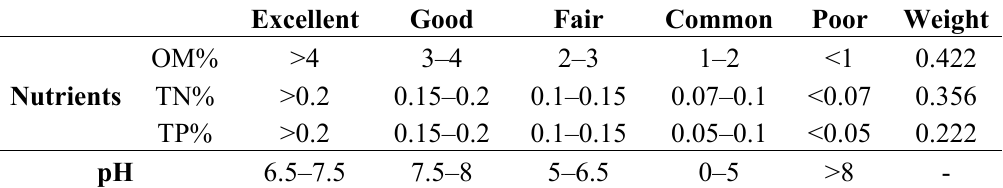
Table 1. The standard of soil nutrients and pH